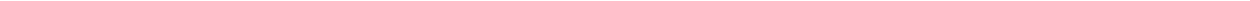
Fig. 2 MarA binding upstream of xseA is important for DNA repair in the presence of cipro fl oxacin. a ChIP-seq data for MarA and σ 70 binding to the xseA locus. Data have been smoothed in a 100 bp window. b DNA sequence upstream of xseA (start codon in blue) is shown. Relevant DNA elements are labelled and arrows indicate orientation. The xseA transcription start (+1) was identi fi ed by Davies and Drabble 33 . The 5 ′ end of the xseA 1 and xseA 2 DNA fragments are indicated by inverted black triangles. The xseA 2 fragment carries the − 36C mutation. c Electrophoretic mobility shift assays with the xseA 1 fragment (+marbox) and the xseA 2 fragment ( − marbox). MarA was at a concentration of 0.3, 1.0 and 1.7 μ M. d DNAseI footprinting experiment, using the xseA 1 fragment, calibrated with a Maxam – Gilbert GA sequencing ladder. Positions relative to the xseA transcription start site (+1) are labelled. Concentrations of MarA are 0.3, 1.0, 1.7, 2.4 and 3.3 μ M. The marbox is indicated by a green line. e Result of a β -galactosidase assay using lysates of JCB387 cells transformed with a reporter plasmid where lacZ expression is controlled by either xseA 1 (+marbox) or xseA 2 ( − marbox). Error bars show standard deviation ( n = 3). f The graph shows OD 650 values obtained for cultures of strain BW25113 xseA ::kan grown in the presence or absence of 0.005 μ g/ml cipro fl oxacin. The BW25113 xseA ::kan cells were transformed with pBR322 derivatives encoding xseA under the control of either the xseA 1 fragment (+marbox) or the xseA 2 fragment ( − marbox). Error bars show standard deviation ( n = 3). g Hoechst-stained BW25113 cells or the xseA ::kan derivative. The term ‘ complement ’ denotes BW25113 xseA ::kan transformed with pBR322 encoding xseA under control of the xseA 1 fragment (+marbox) or the xseA 2 fragment ( − marbox). The scale bar is 5 μ m and all panels are the same scale. h A pulse fi eld gel electrophoresis experiment to analyse chromosomal integrity of BW25113 (WT) or the xseA ::kan derivative ( Δ ). The xseA ::kan derivative of BW25113 was transformed with either empty pBR322 ( Δ 1 ), pBR322 encoding xseA under the control of xseA 1 fragment ( Δ 2 ) or xseA 2 ( Δ 3